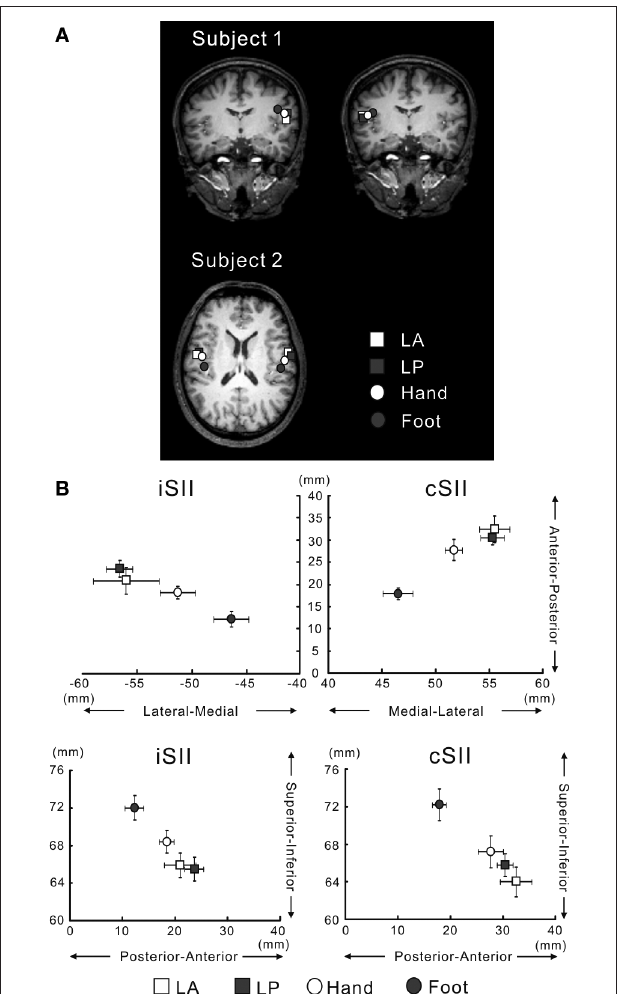
FIGuRE 5 | (A) ECD locations for LA, LP, Hand and Foot superimposed on 2D MR images in two representative subjects. Source locations of Subject 1 are superimposed on the coronal plane and those of Subject 2, on the axial plane. The ECDs for bilateral SII responses were located in the upper bank of the Sylvian fissure in the left and right hemispheres. White and gray squares indicate the locations for LA and LP, respectively. White and gray circles indicate the locations for Hand and Foot, respectively. (B) Schematic drawing of spatial relationships of the ECDs for SII among each stimulation point. Upper figures depict the medial-lateral and anterior–posterior directions. Lower figures illustrate the superior–inferior and anterior–posterior directions. LA and LP are located most lateral, anterior and inferior, while the ECD for Foot is located most medial, posterior, and superior. Bars indicate standard error (SE). Adopted from Sakamoto et al.